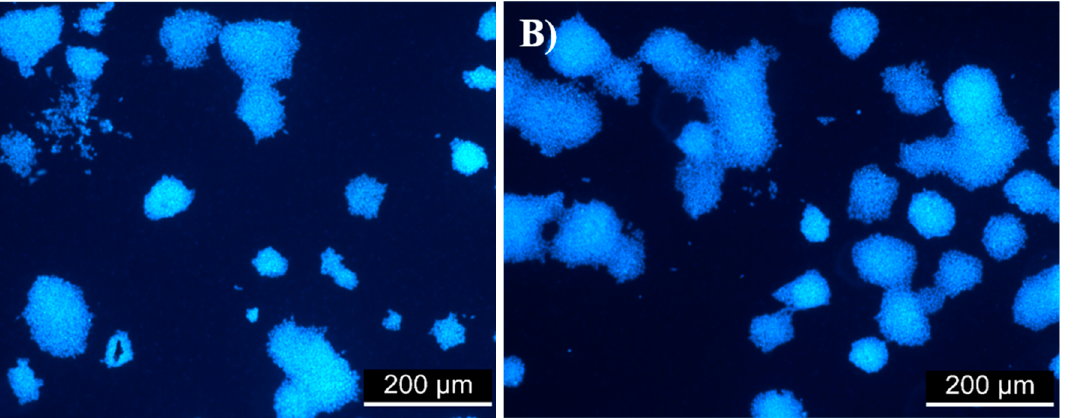
Figure 6. Mouse embryonic cells (Line R1) on ( A ) PET uncoated with 0.1% gelatine and ( B ) DC 8500 uncoated with 0.1% gelatine after 120 h of cultivation.